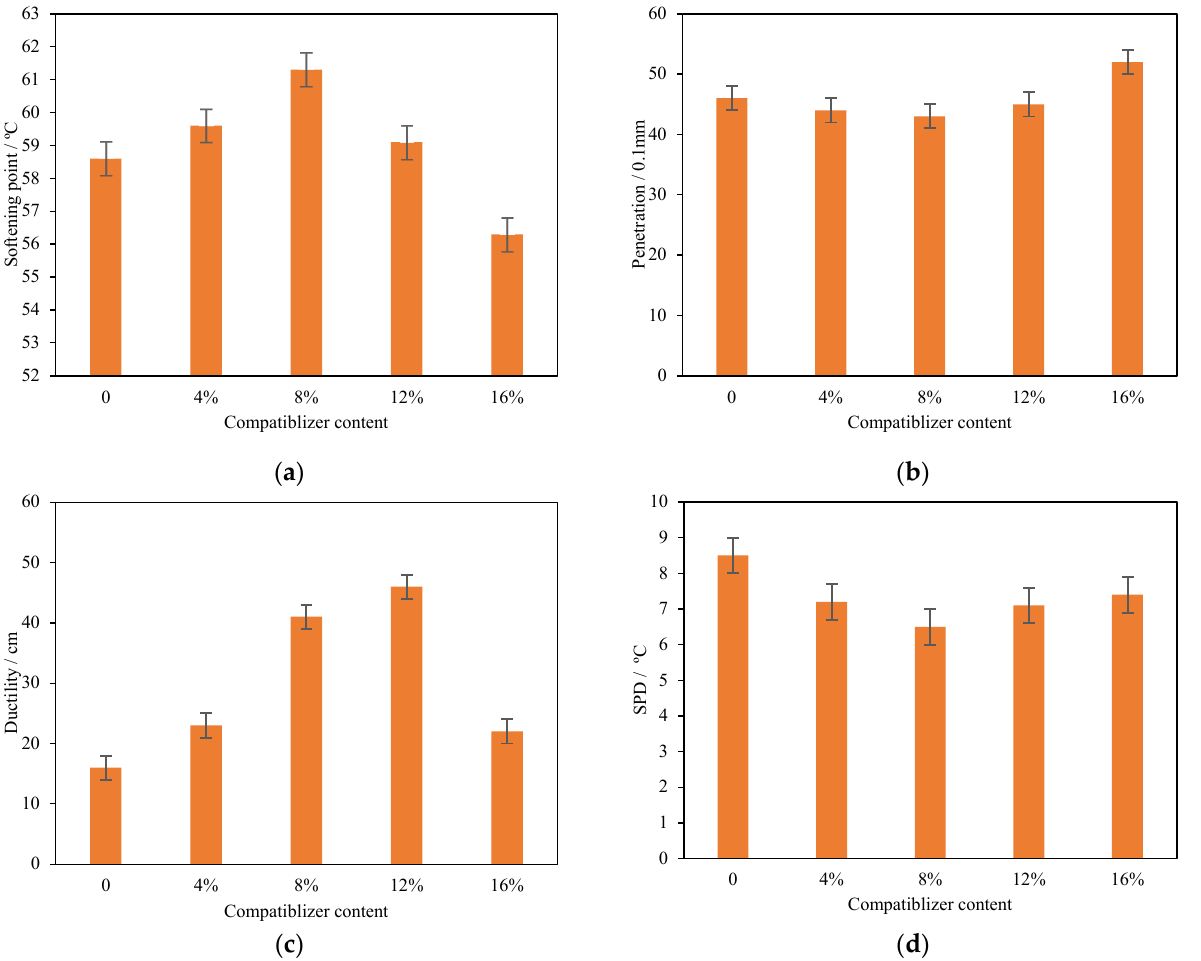
Figure 3. Properties of the 20% PCB-NMF-modified asphalt with different compatibilizer contents: ( a ) softening point; ( b ) penetration; ( c ) ductility; ( d ) SPD.